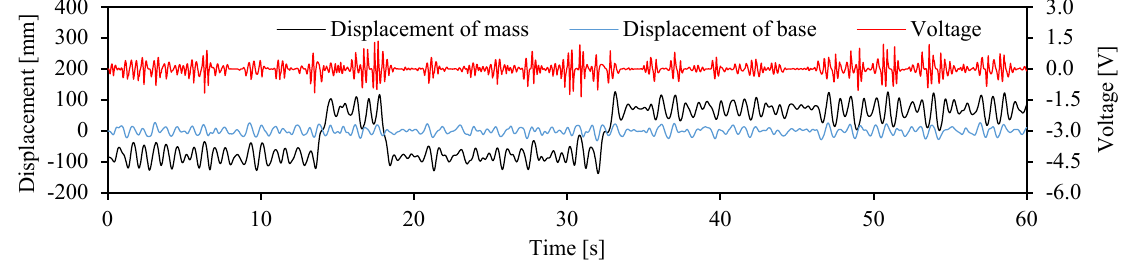
When the periodic signal frequency was 1.3 Hz, as shown in Figure 19, the vibration of the mass block became more intense, and a stochastic resonance phenomenon occurred that caused the monostable vibration of the mass block to evolve to a bi-stable vibration with standard deviations of 77.64 and 10.85 mm in the vibration displacements of the mass block and support point, respectively; consequently, 2.08 mW of power was output. Figure 18. Results based on co-excitation of random and 1.0 Hz periodic signals.